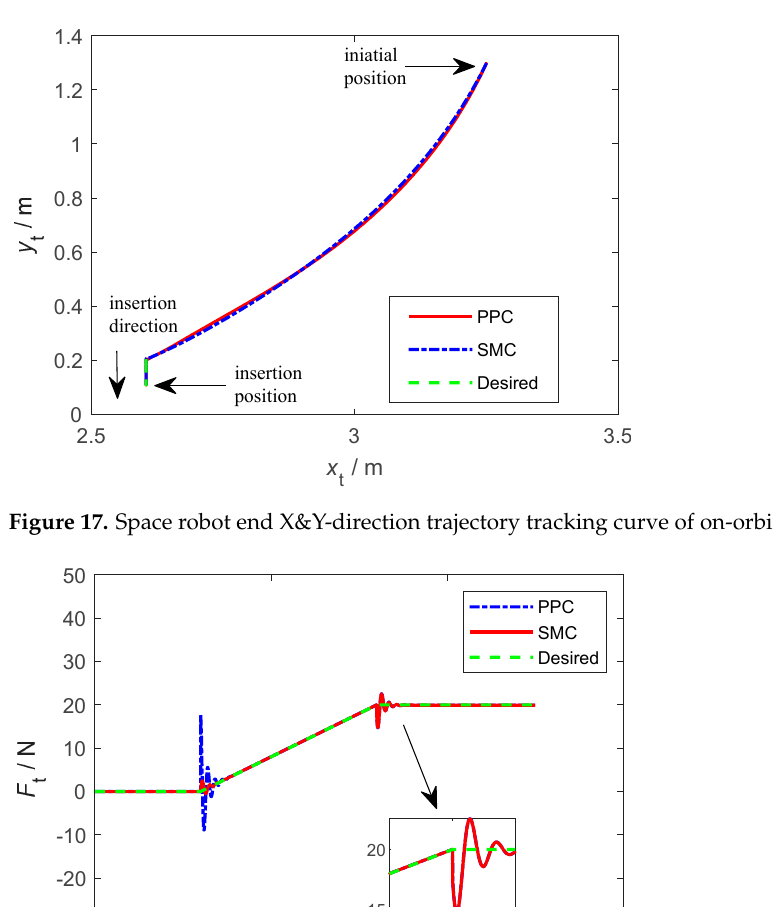
Figure 18. Output force of space robot end tracking curve of on-orbit extraction operation.